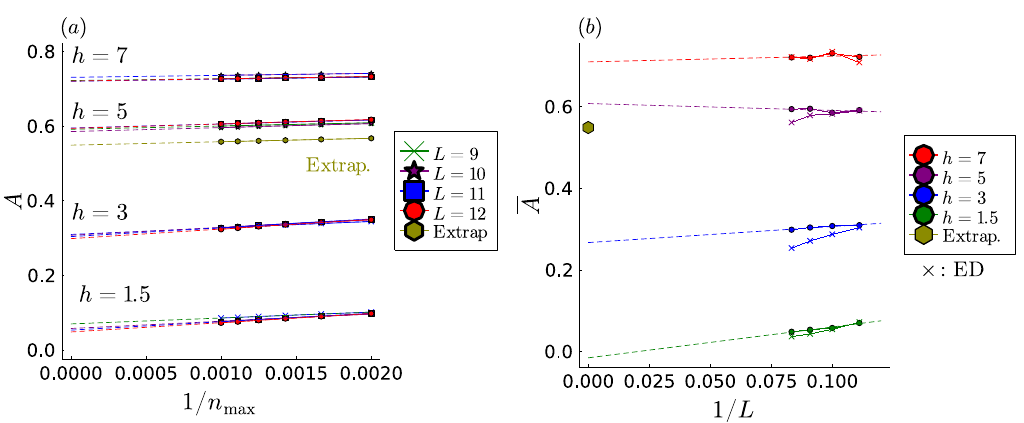
Figure 5: (a)The finite- n extrapolation of the disorder-averaged amplitude of the max zero-frequency delta function for several system sizes L and disorder strengths h